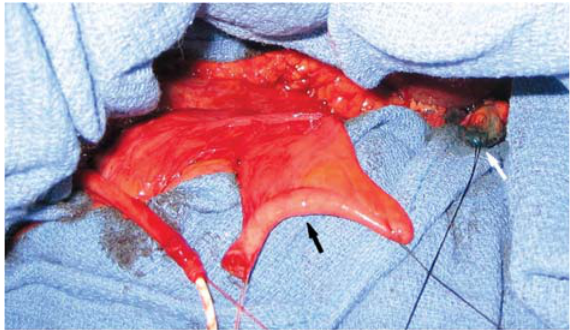
Figure 1 – Proximal ureteral defect measuring 8-10 cm with appendix rotated into position (black arrow). Dark suture at right renal pelvis (white